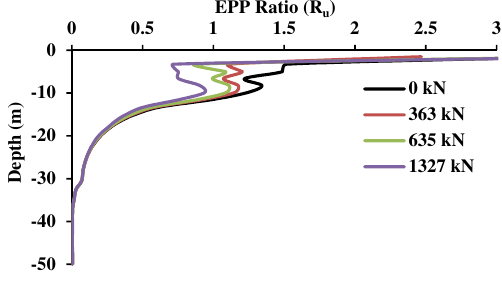
Fig. 10 Profile of R of RCD soil under scaled IMV motion for various u superstructure